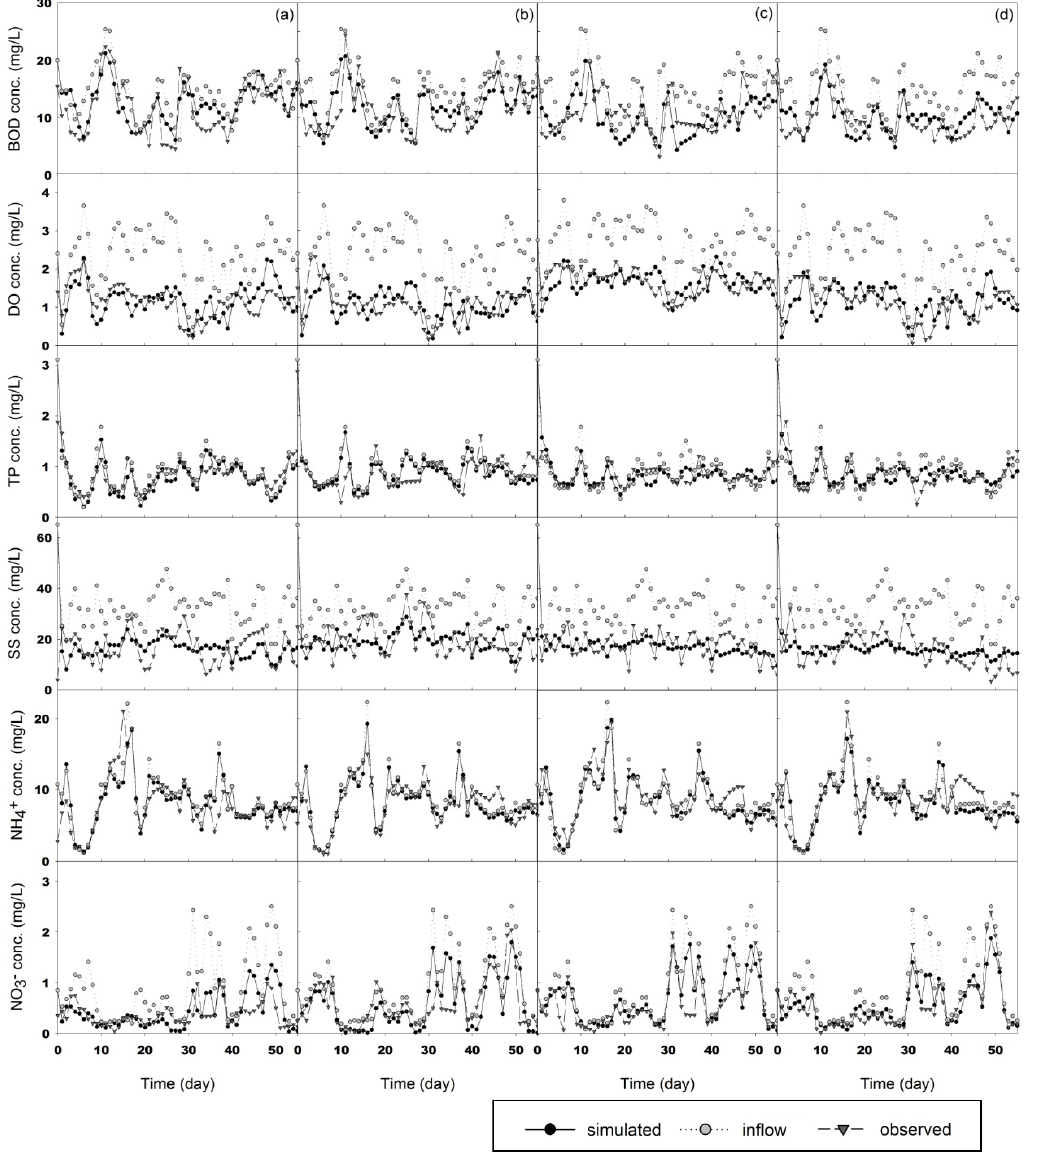
− outflow results and measured data 3